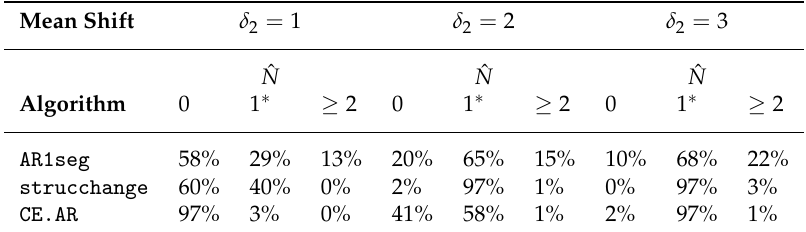
Table 2. The estimated number of change-points under scenario 1.